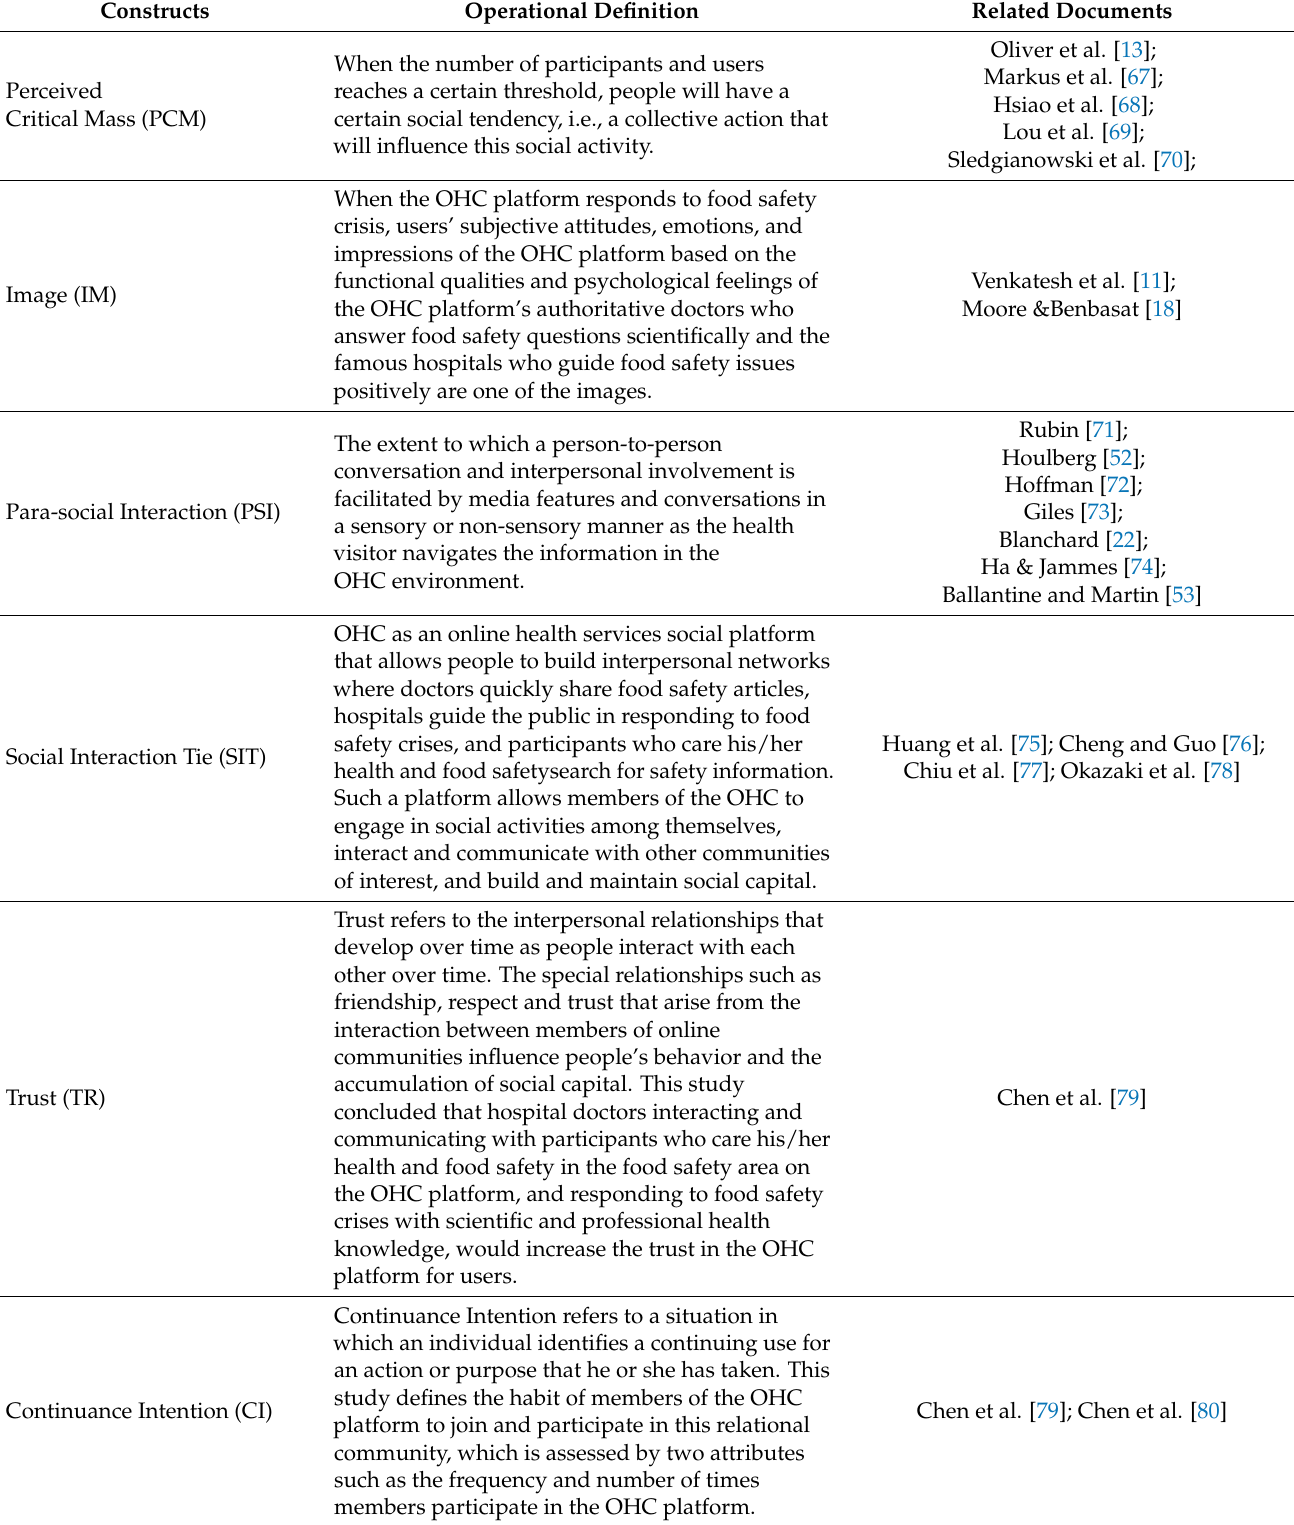
Table 1. Operational